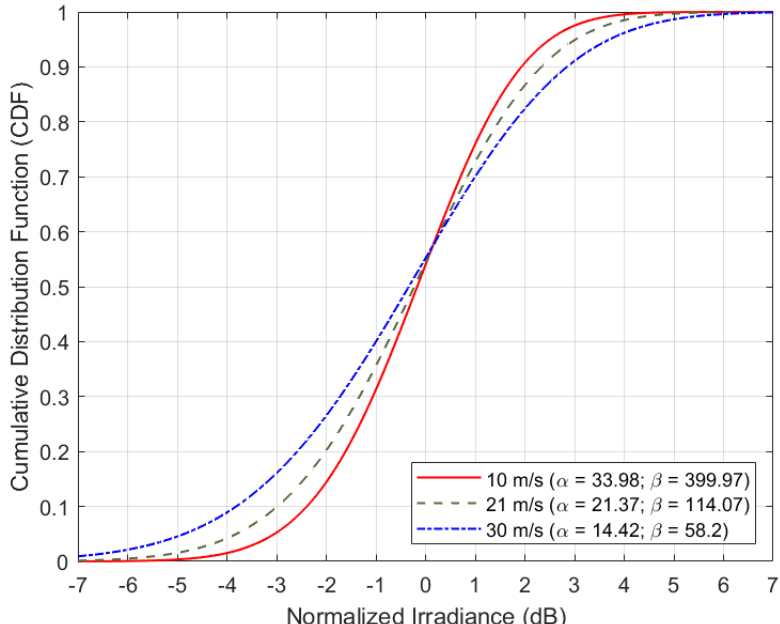
Figure 8. Cumulative distribution function of the power loss that turbulence-induced beam wander and scintillation introduces in the uplink direction of the optical feeder link in case of an untracked collimated beam with λ = 1.55 µ m, W 0 = 10cm, ζ = 52.61deg, A 0 = 1.7 × 10 − 14 m − 2/3 . The ground station site is assumed next to Madrid ( h 0 = 864m) and the position of the GEO satellite is assumed at 19.2 ◦ East ( H = 36,000km). Wind speeds: v = 10m/s (solid red line), v = 21m/s (dashed green line), and v = 30m/s (dashed-dotted